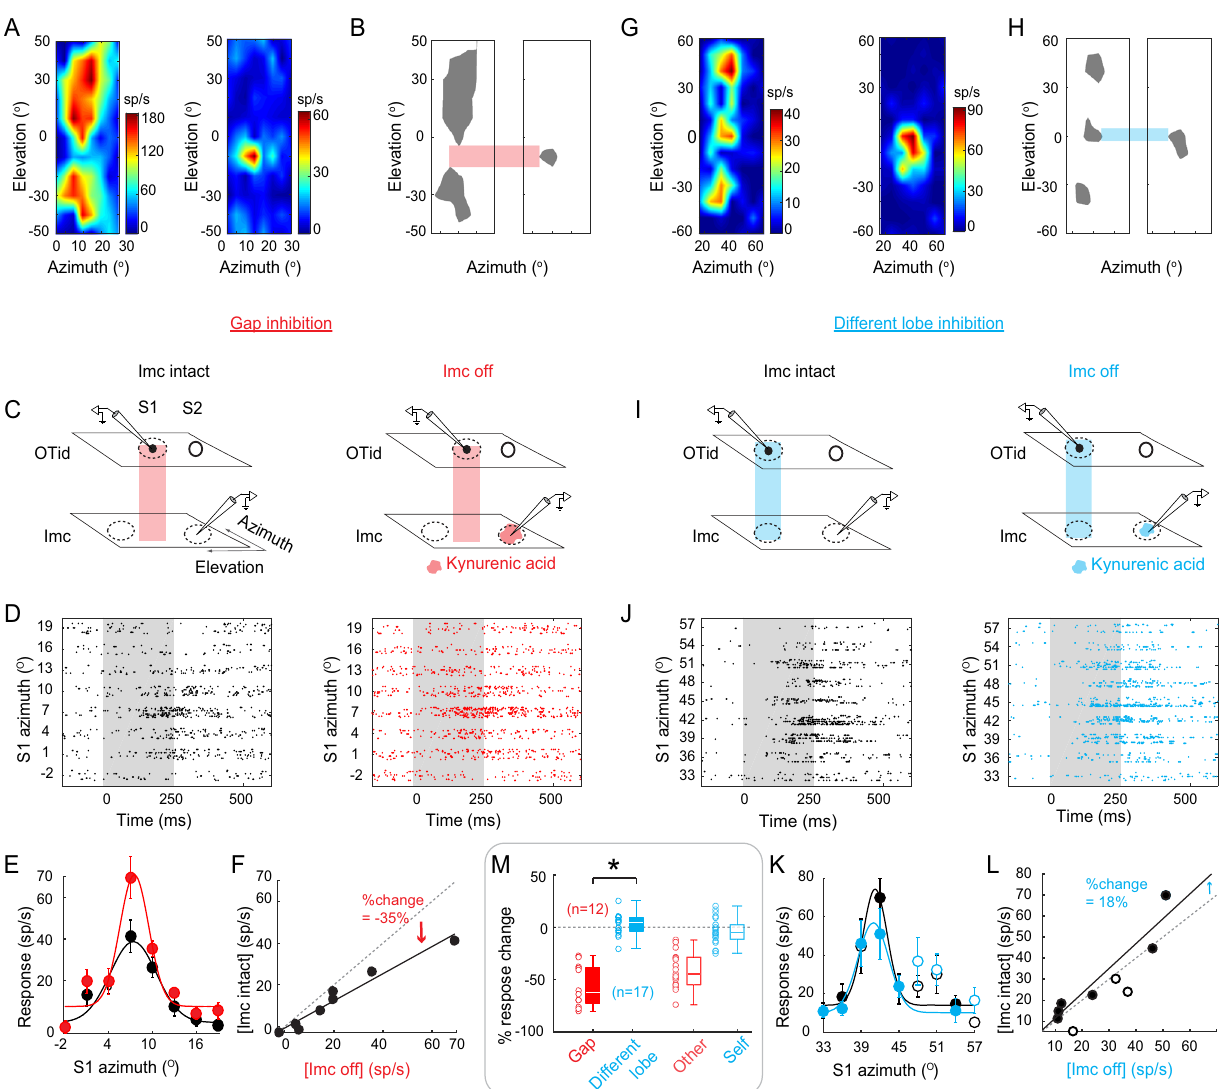
Fig. 4 Barn owl midbrain selection network contains multi-holed donut-like inhibitory motif operating across 2-D sensory space (azimuth x elevation). A – F Measurement of the strength of net “ gap ” inhibition from Imc → OTid with paired recordings in owl Imc and OTid. A Spatial receptive fi elds (RFs) of an Imc neuron (left) and an OTid neuron (right) from a paired Imc-OTid recording experiment. Imc RF is two-lobed 51 (text; Fig. S3B – D; Methods). OTid RF lies in the gap between the lobes of the Imc RF. B Binarized versions of RFs in ( A ), at 60% max. fi ring rate in each case. Red horizontal bar: highlights the relative position of OTid RF to Imc RF lobes. C – F Conventions as in Fig. 3C – F. C Red vertical bar indicates that OTid RF is in the gap between Imc RF lobes. E mean ± s.e.m ( n = 10). F Line: Best fi t straight line; slope = 0.65, R 2 = 0.95. % change in responses directly estimates the strength of inhibition at this OTid neuron due to Imc (here, − 35%; Methods; conventions as in Fig. 3F). G – L Measurement of the strength of net “ different lobe ” inhibition from Imc → OTid with paired recordings in Imc and OTid. Conventions as in ( A – F ). G , H Three-lobed spatial RF of an Imc neuron (left; Fig. S3E – G; Methods). RF of OTid neuron overlaps (blue bar) with one of the lobes of Imc neuron ’ s RF. K mean ± s.e.m ( n = 10). L Line: Best fi t straight line; slope = 1.18, R 2 = 0.9. % change in responses directly estimates the strength of inhibition at this OTid neuron due to Imc (here, 18%; Methods; conventions as in Fig. 3F). M Population summary of strength of net “ gap ” inhibition (red; n = 12), and strength of net “ different lobe ” inhibition (blue; n = 17) from Imc → OTid. Open red and blue box plots: reproduced from Fig. 3L. p = 1.02e-6 (red vs. 0), p = 0.35 (blue vs. 0); * p < 0.05, p = 8.69e-11 (red vs. blue), paired two-sided t tests with HBMC correction. Box plot conventions as in Fig. 3L. See also Fig. S3. Source data are provided as a Source Data fi